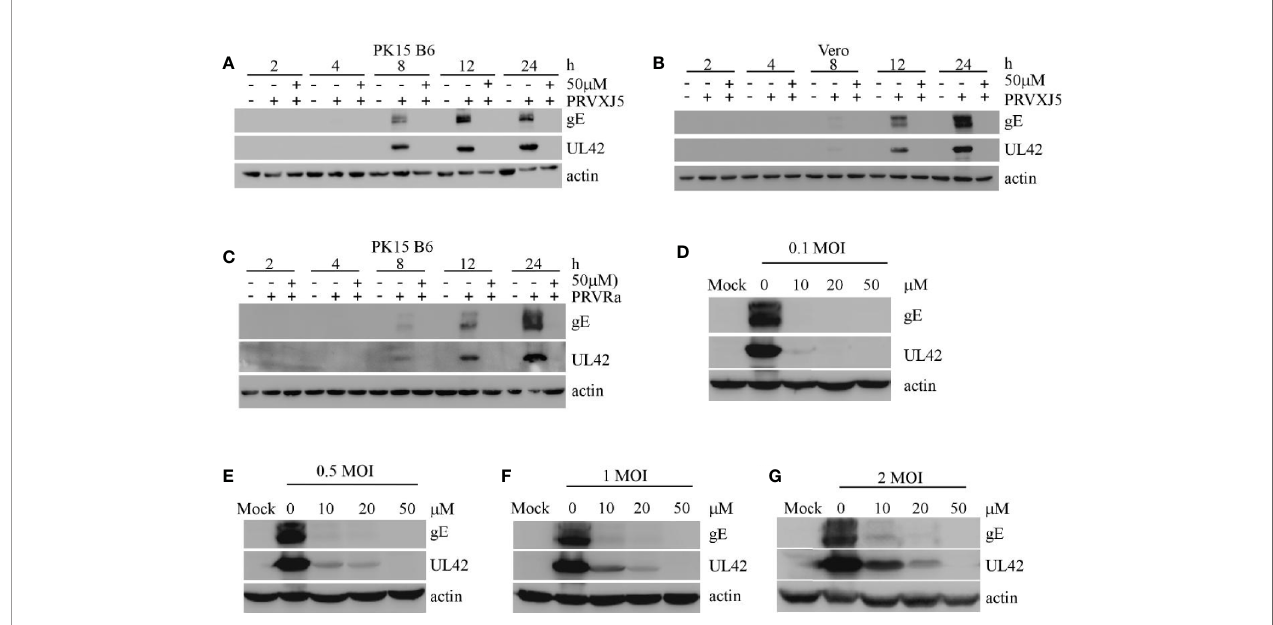
FIGURE 2 | ( – )-Epigallocatechin-3-gallate (EGCG) inhibited pseudorabies virus (PRV) infection activity at differing timepoints, for differing PRV strains and MOIs. (A, B) PK-15 and Vero cells were pretreated with 50 m M EGCG followed by infection with PRV XJ5 (MOI=0.1). At 2, 4, 8, 12, and 24 hpi, Western blot was used to evaluate PRV-gE, UL42 and b -actin protein expression. (C) PK15 B6 cells were pretreated with 50 m M EGCG followed by infection with PRV Ra (MOI=0.1). At 2, 4, 8, 12, and 24 hpi, Western blot was used to evaluate PRV-gE, UL42, and b -actin protein expression. (D – G) PK15 B6 cells were pre-treated with 10, 20, or 50 m M EGCG for 1 h before infection with PRV XJ5 at MOI=0.1, 0.2, 1, or 2, then cultured with 10, 20, or 50 m M EGCG. At 24 hpi, cell samples were collected and lysed for Western blot to analyze changes in gE, UL42 and b -actin protein